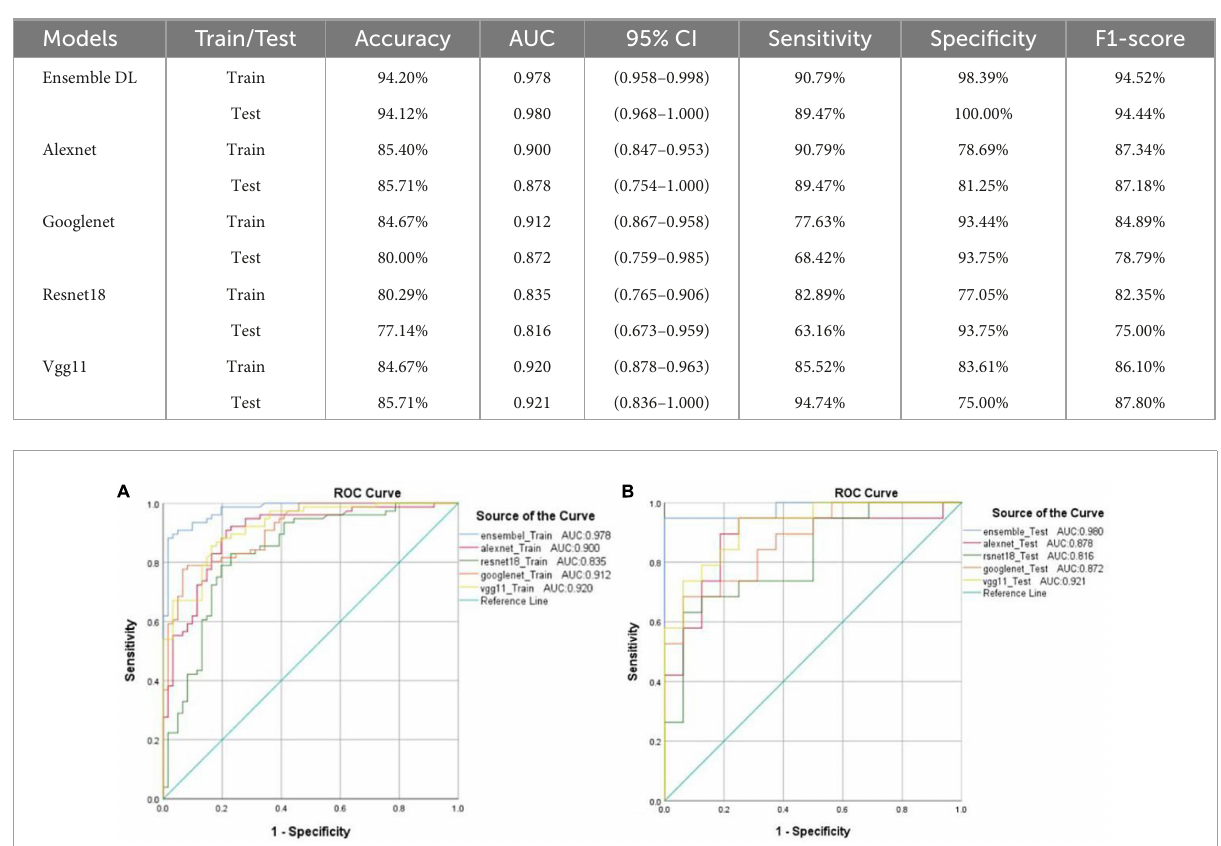
TABLE 1 The performances of the models of the models.